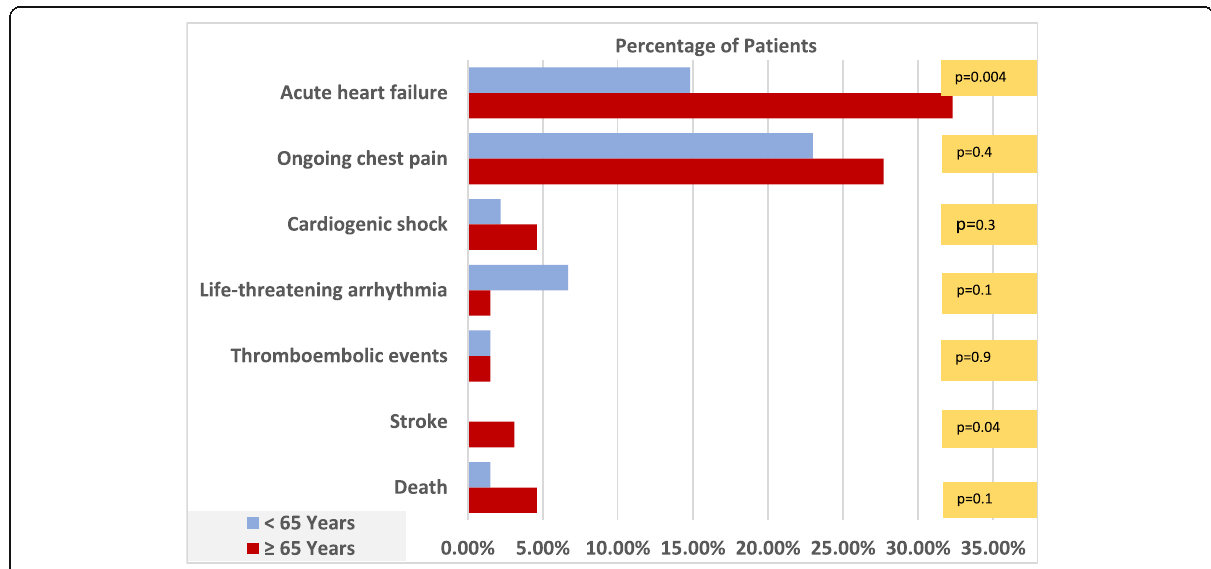
Fig. 5 In-hospital complications in NSTE-ACS patients a according to age